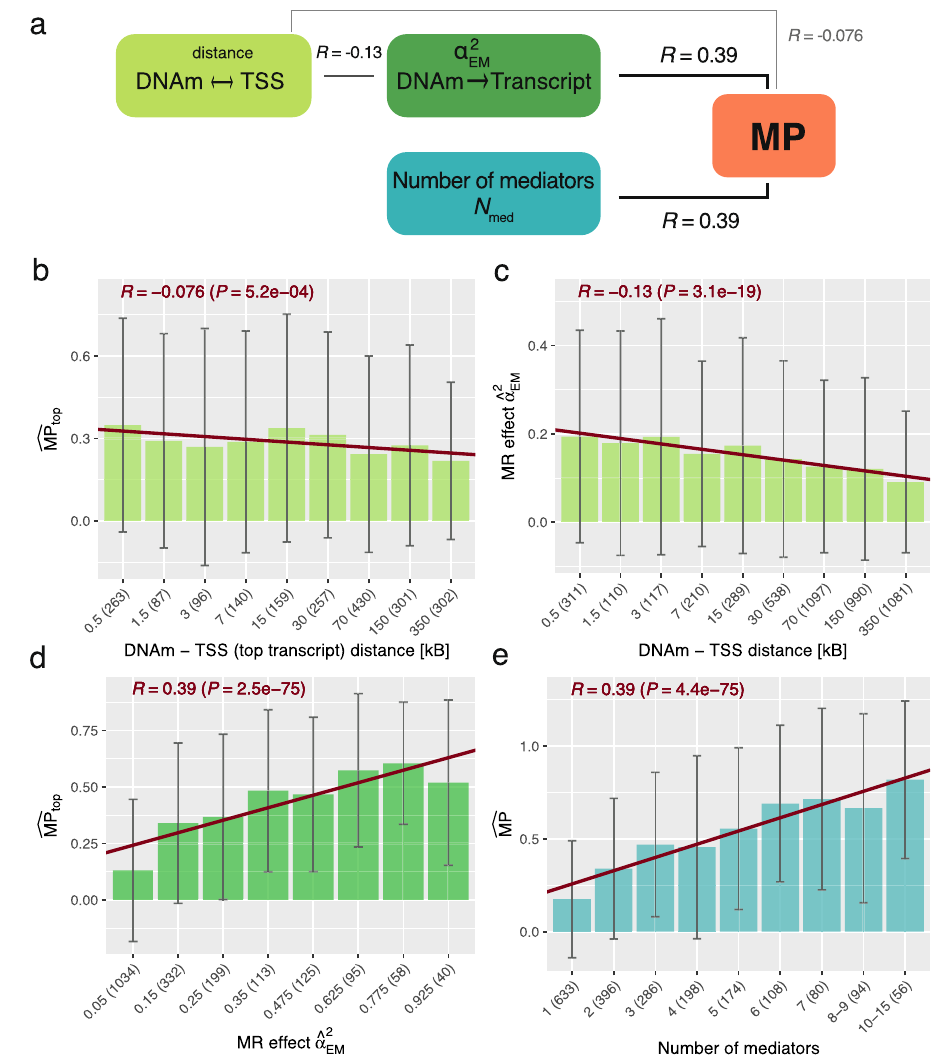
Fig. 4 | Exposure-to-mediator regulatory strength and number of mediators explaining mediation proportions (MPs). a Summary of the correlations ( R ) between MP (red) and DNA methylation (DNAm)-to-transcript causal MR effects ( ^ α 2 EM ,darkgreen),distancebetweentheDNAmsiteandtranscriptionstartsite(TSS, light green) and number of mediators ( N med , blue). b Average MP through top transcript( d MP top ) of DNAm-traitpairsstrati fi ed according to the distancebetween the DNAm site and the TSS of the top transcript. All DNAm-trait pairs with at least one mediator were included (2069 pairs). c Average MR causal effects ( ^ α 2 EM ) of DNAm-transcript pairs strati fi ed according to the distance between the DNAm site and the TSS. Unique DNAm-transcript mediator pairs across all DNAm-trait pairs were included (4743 pairs). d Average d MP top of DNAm-trait pairs strati fi ed